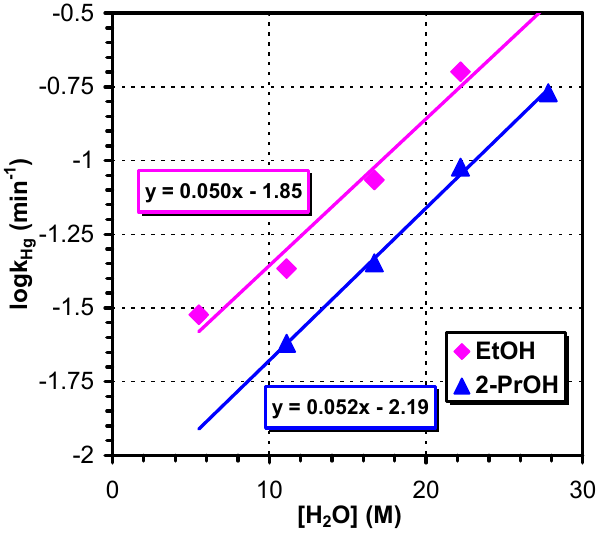
Figure 6. Variation of the logk Hg values with the water concentration for the protic co-solvents. Experimental conditions: [1,5-ICAN] = 2.5 × 10 − 6 mol/L, [HgCl 2 ] = 1.2 × 10 − 3 mol/L and T = 25 °C. Table 2. The pseudo first-order rate coefficients for the reaction of 1,5-ICAN with water in different water/protic co-solvents mixtures and HgCl 2 . The errors of the obtained rate coefficients were within